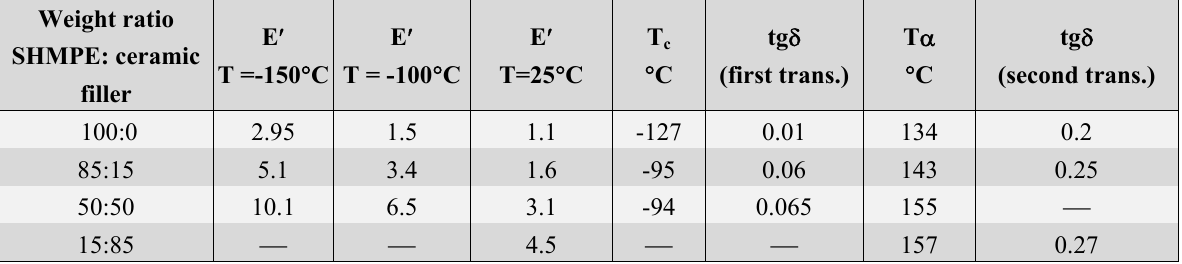
Table 7. Dynamic mechanical characteristics of the nanocomposites of Y SHMPE.